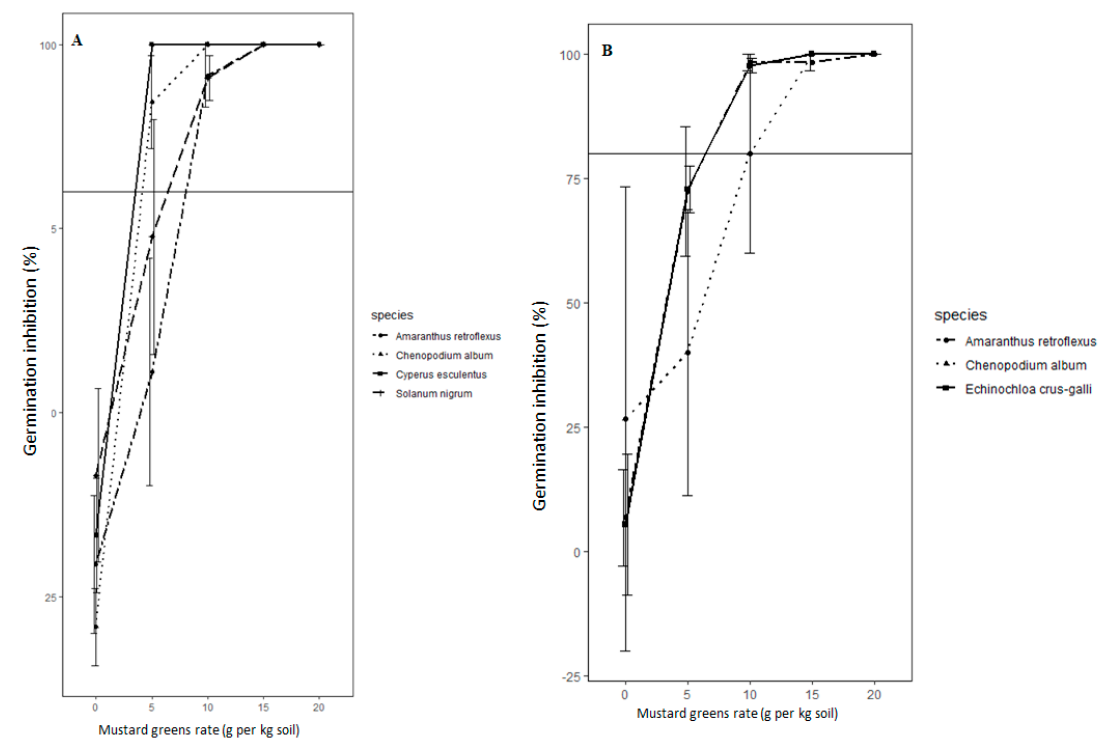
Figure 2. Effect of different rates of mustard greens biomass as anaerobic soil disinfestation (ASD) carbon sources ( A ). on weed seed mortality under growth chamber conditions ( B ). on inhibition of weed germination from a natural seed bank, which is calculated by (number of seedlings in uncovered aerobic control-number of seedlings in the treatment) × 100/number of seedlings in aerobic control). Y -axis indicates the inhibition of weed germination in two independent experiments, each with three replications. The line indicates the 80% mortality and 80% inhibition acceptable for weed suppression, respectively. Error bars indicate standard error.